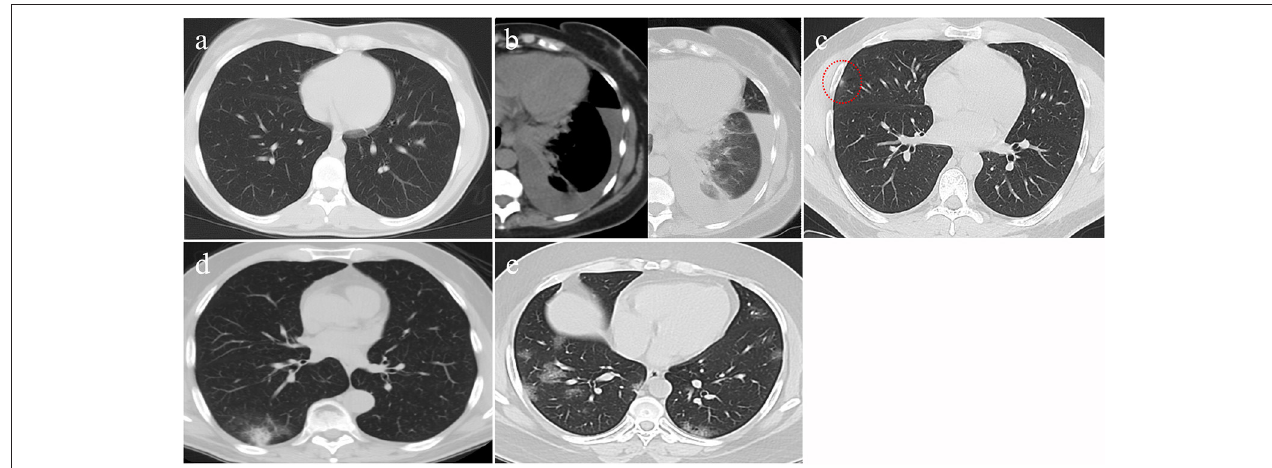
FIGURE 1 | CT findings of different CO-RAD stages. (a) Normal CT findings, in keeping with CO-RAD1. (b) CT showed a left lower lobar patchy area of consolidation associated with moderate pleural effusion. This picture is suggestive of bacterial pneumonia (in keeping with CO-RAD2). Note that pleural effusion is very unlikely to occur with COVID-19 pneumonia. (c) A very tiny right middle lobar patchy area of faint ground glass opacity (red dashed circle), in keeping with CO-RAD3. (d) CT chest showed right lower lobar patchy area of ground glass veiling, mounting to consolidation, in keeping with CO-RADS 4. (e) Bilateral, mainly peripheral and lower lobar, small patchy areas of ground glass opacity, in keeping with CO-RADS 5.